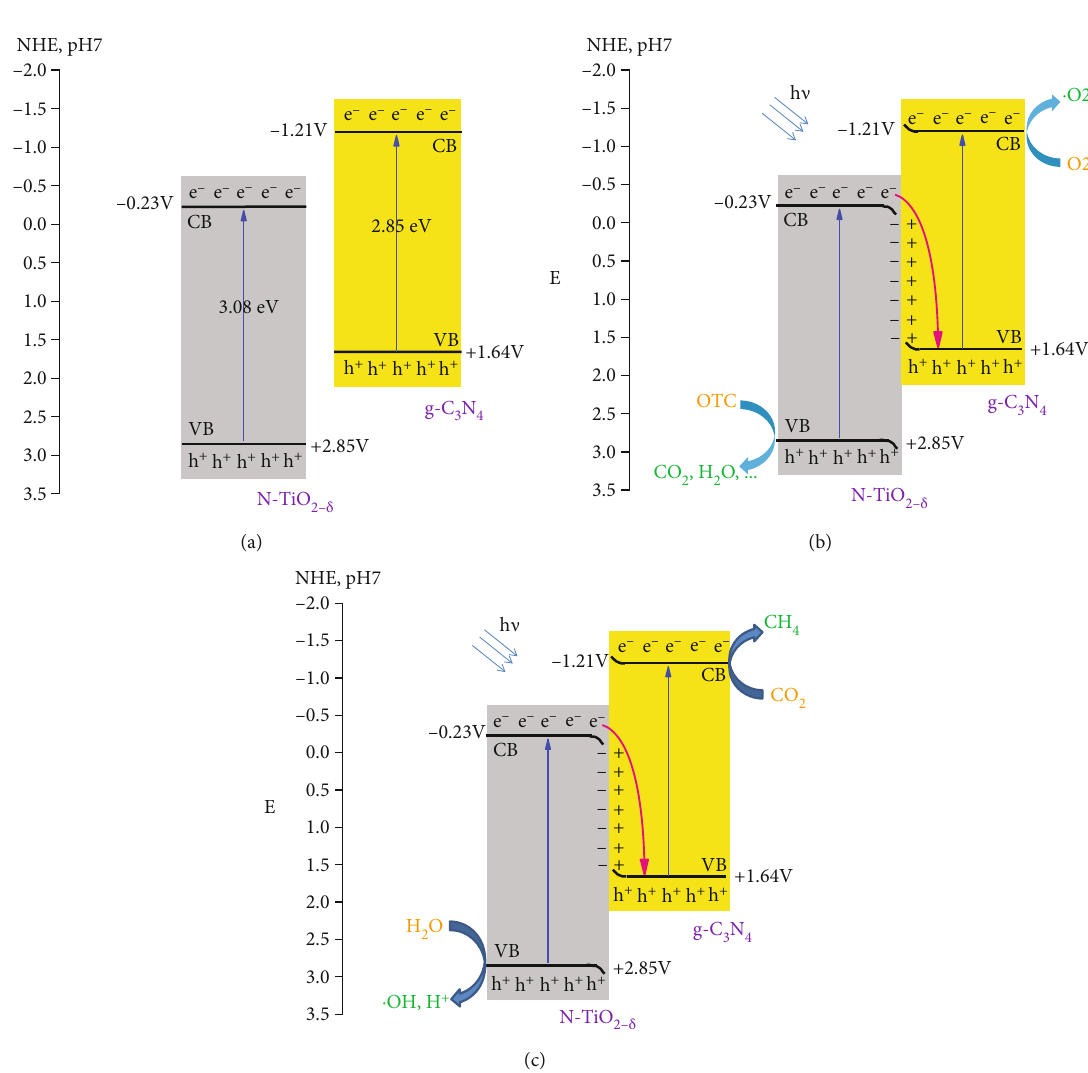
and g-C N before contact (a), N-TiO 2- δ 3 4 photoreduction mechanism 2